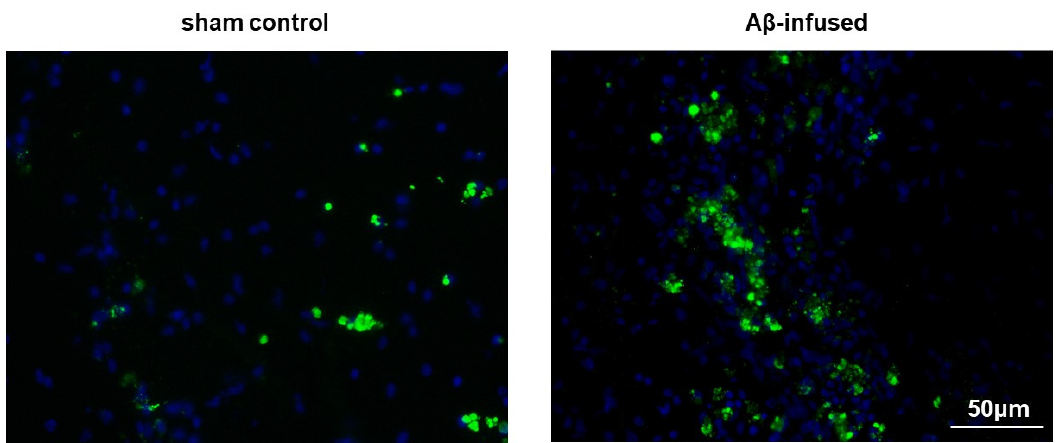
Figure 2. Representative images of hippocampus section stained with anti-A β antibody (green fluorescence) in sham control and A β (1–42) -infused rat model. Cell nuclei were counterstained with DAPI (blue fluorescence). Scale bar: 50 µ m.